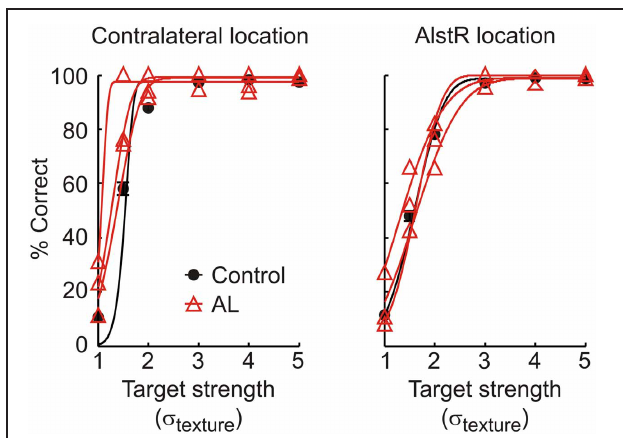
FIGURE 4 | Performance of monkey V in the detection task for control and injection experiments, for targets shown at the contralateral and AlstR location. Black circles and line: Average behavior and psychometric function in control experiments (error bars: SEM). Red triangles and lines: Performance (raw data and fit) in individual AL injection experiments.